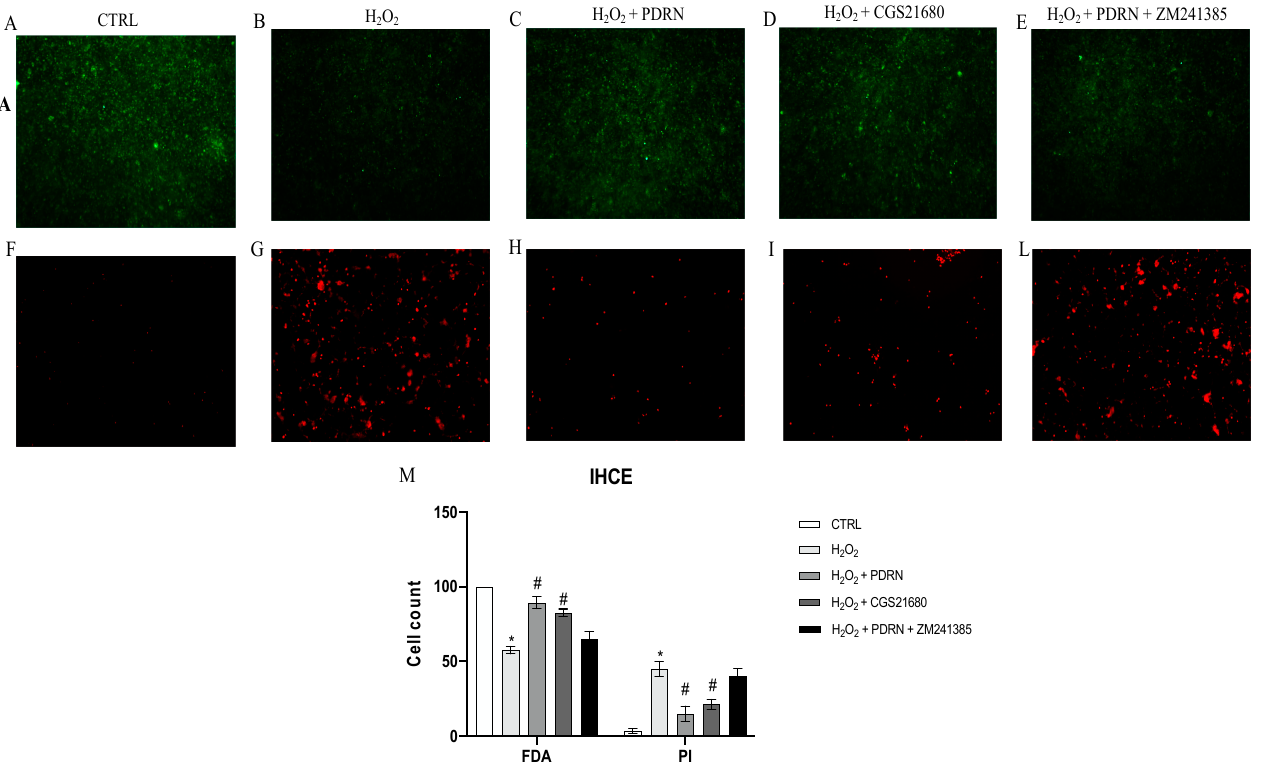
Figure 1. The figure shows the availability of the IHCE cell line treated with PDRN, as evaluated by FDA/PI staining. In panels ( A – E ) the green color staining indicates viable IHCE cells; in panels ( F – L ) the red staining indicates IHCE cells in apoptosis. Panel ( M ) shows the IHCE cell count. The data are expressed as means ± SD. * p < 0.0001 vs. CTRL; # p < 0.0001 vs. H 2 O 2 .